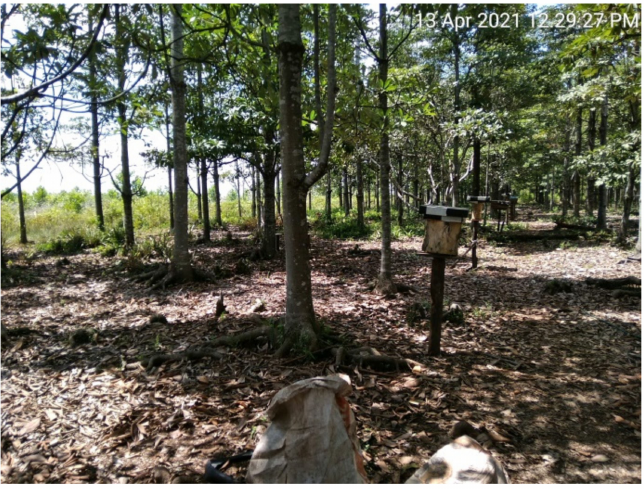
Figure 3. Jelutung trees and stingless bees.